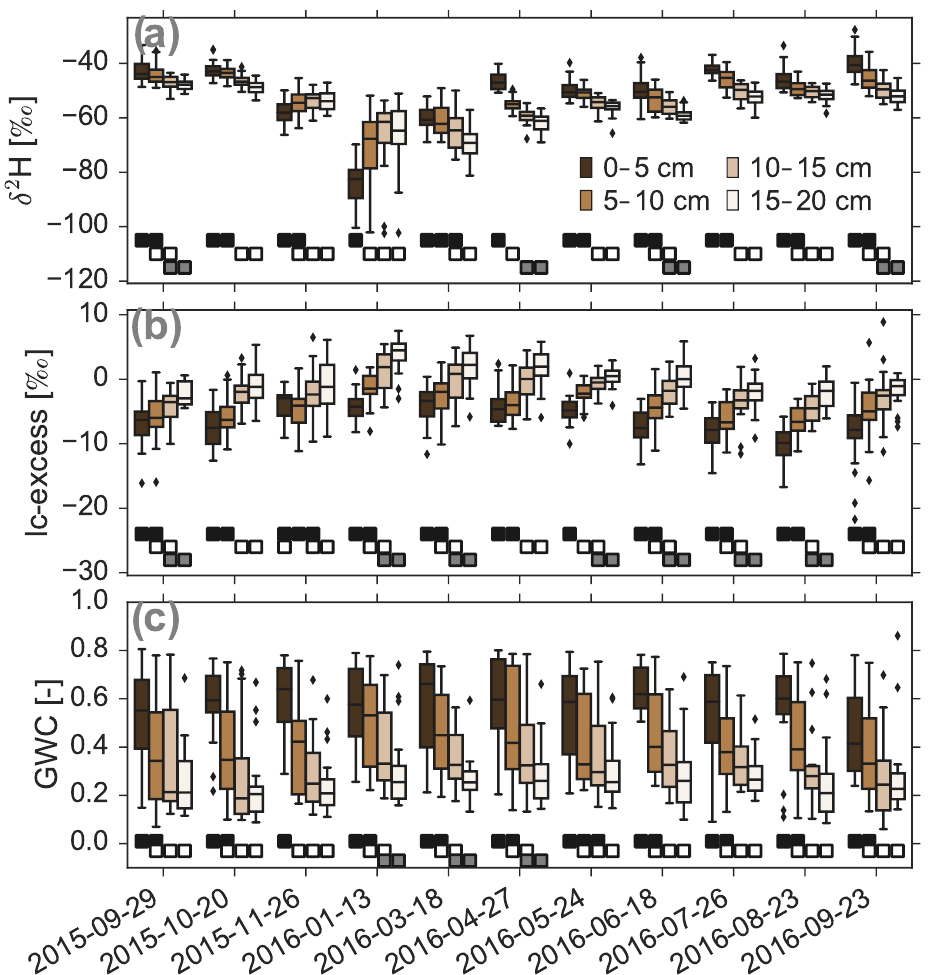
Figure 7. Differences of (a) δ 2 H, (b) lc-excess, and (c) gravimetric water content (GWC) over depth for each sampling day. Black, white, and gray squares below the box plots indicate significant differences between the depth for each sampling day according to the Dunn test (i.e. same color reflects similarities; different colors differences). For example, for 29 September 2015, samples from 0 to 5cm depth were significantly different from samples from the depth 10–15cm and 15–20cm, but not significantly different to samples from 5–10cm depth.